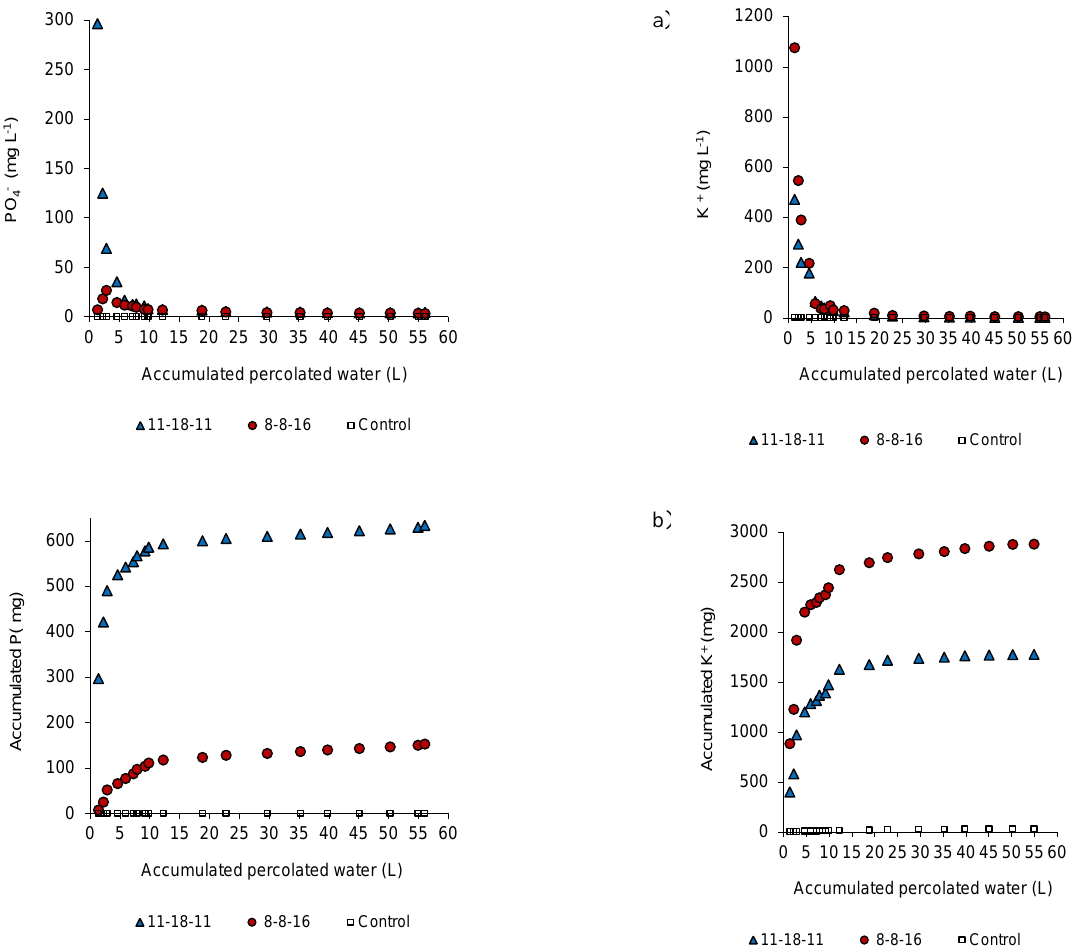
Figure 5. Phosphorus concentrations in leachates (a) and accumulated P losses (b) from fertilized and control columns along the experiment (average of three replicates).